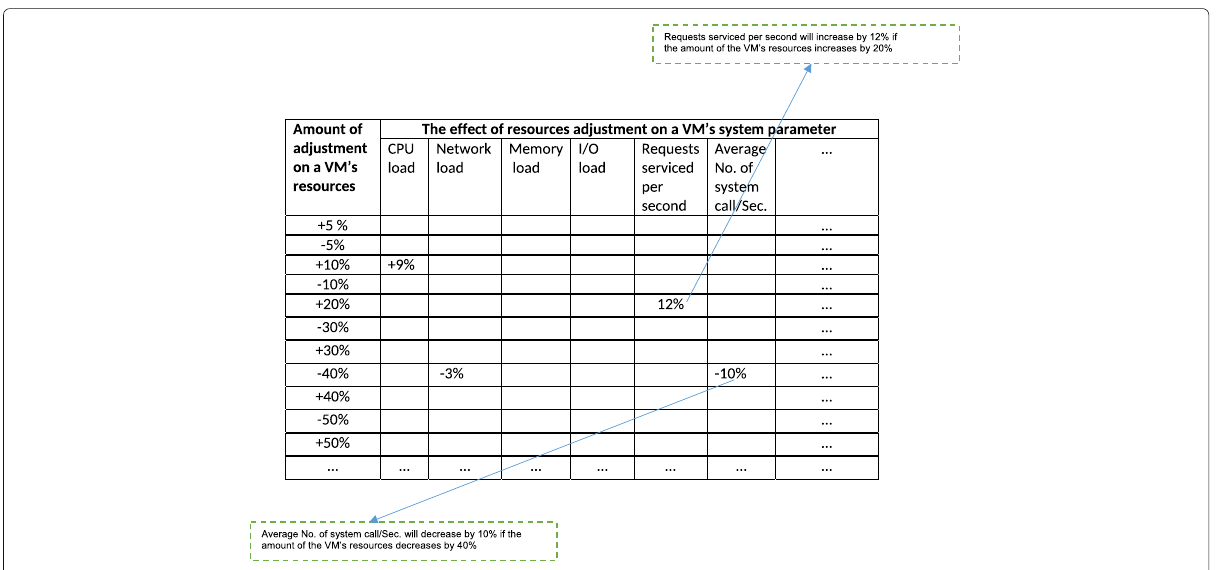
Fig. 3 Table used for filtering out the effect of resources adjustments on a VM system